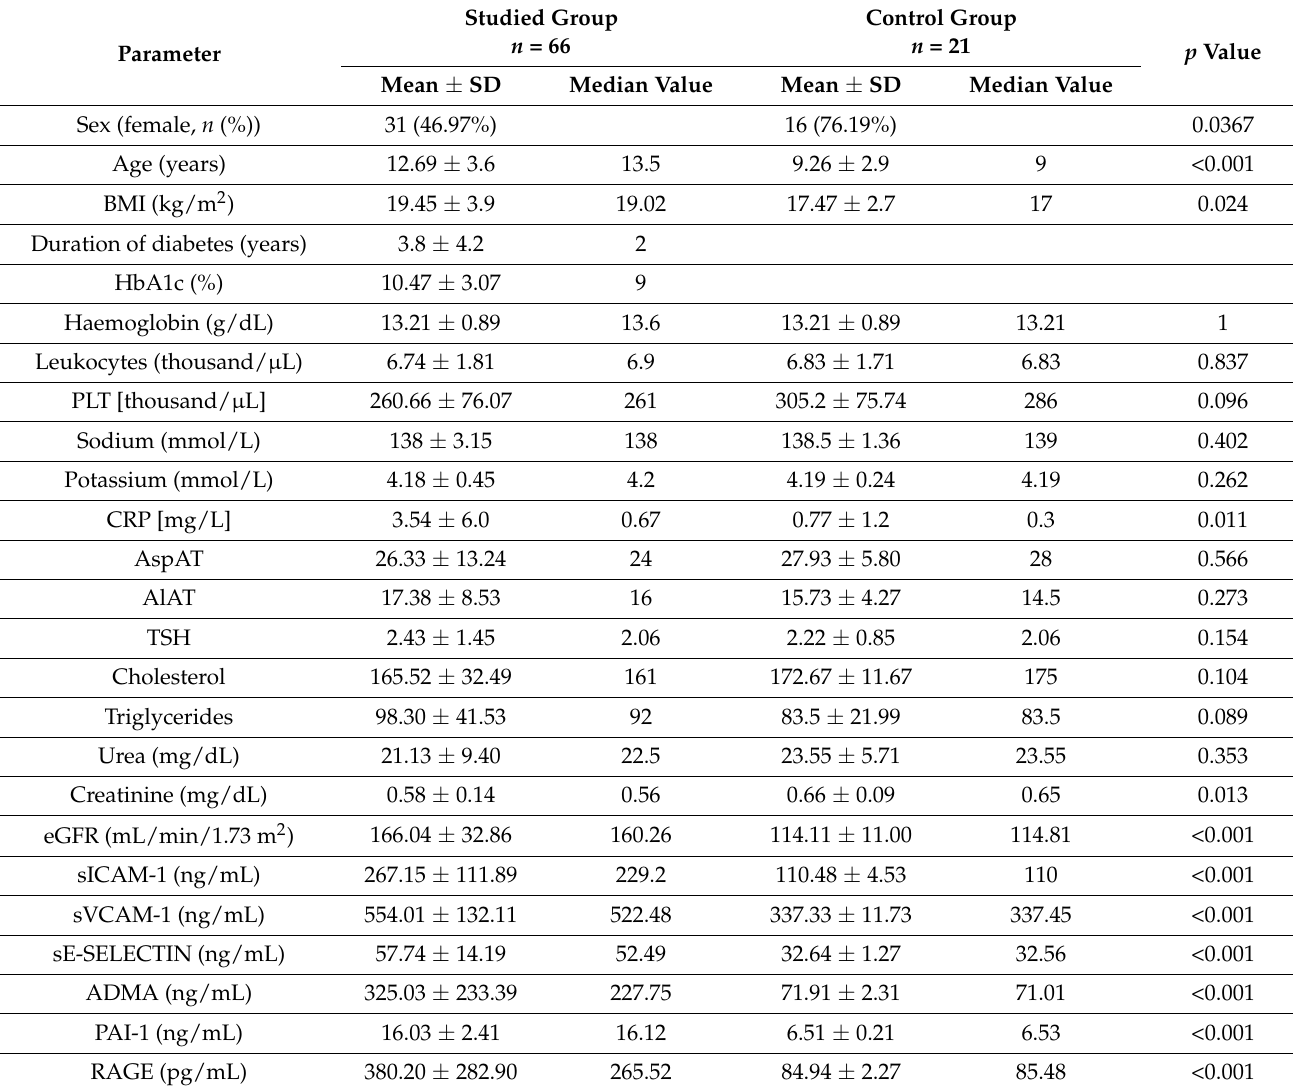
Table 1. Baseline data in diabetic patients (studied group) and in control